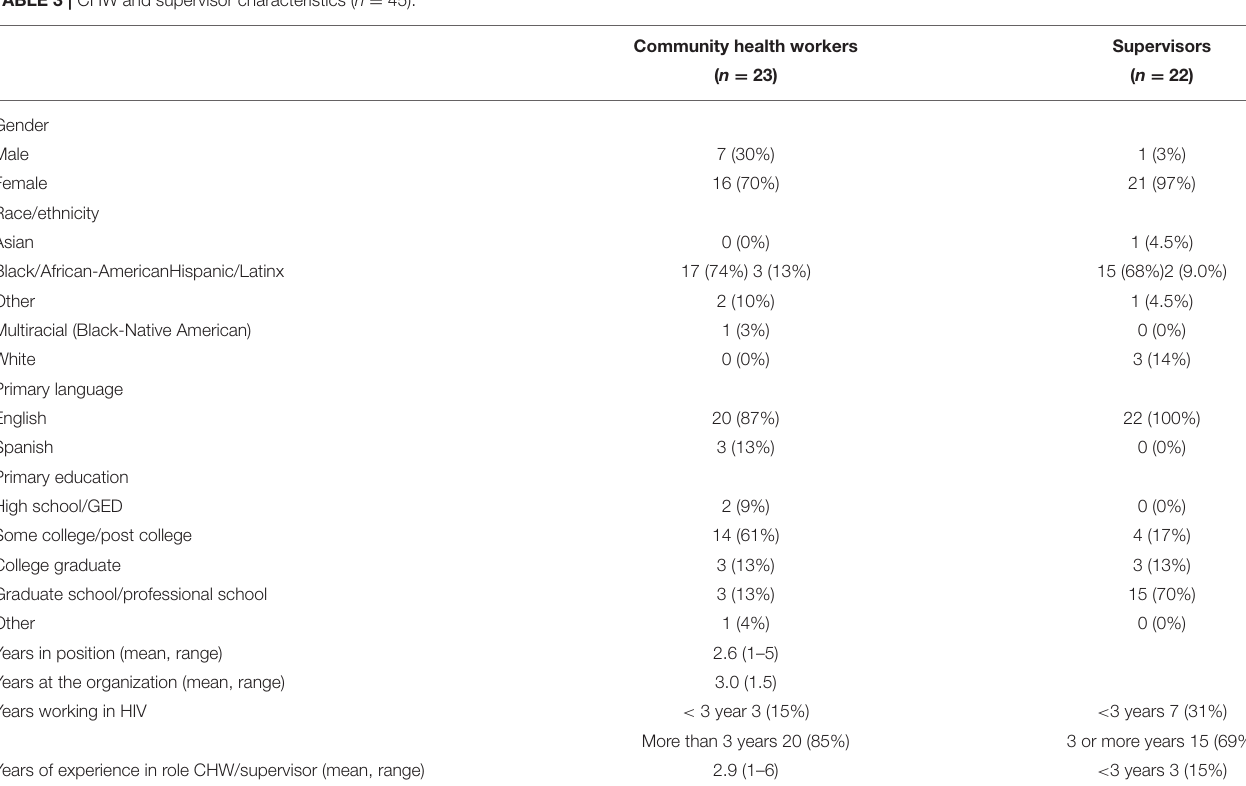
TABLE 3 | CHW and supervisor characteristics ( n =